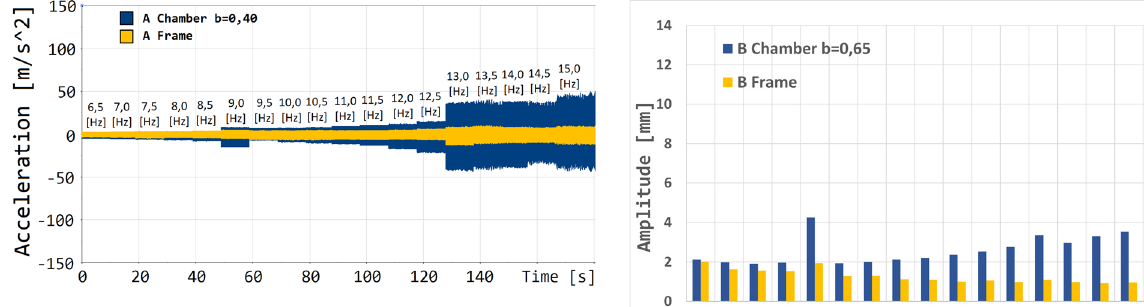
Figure 3: Quasi steady start up. Accelerations of the chamber and drive frame for the chamber fi lling degree equal to 0.4.